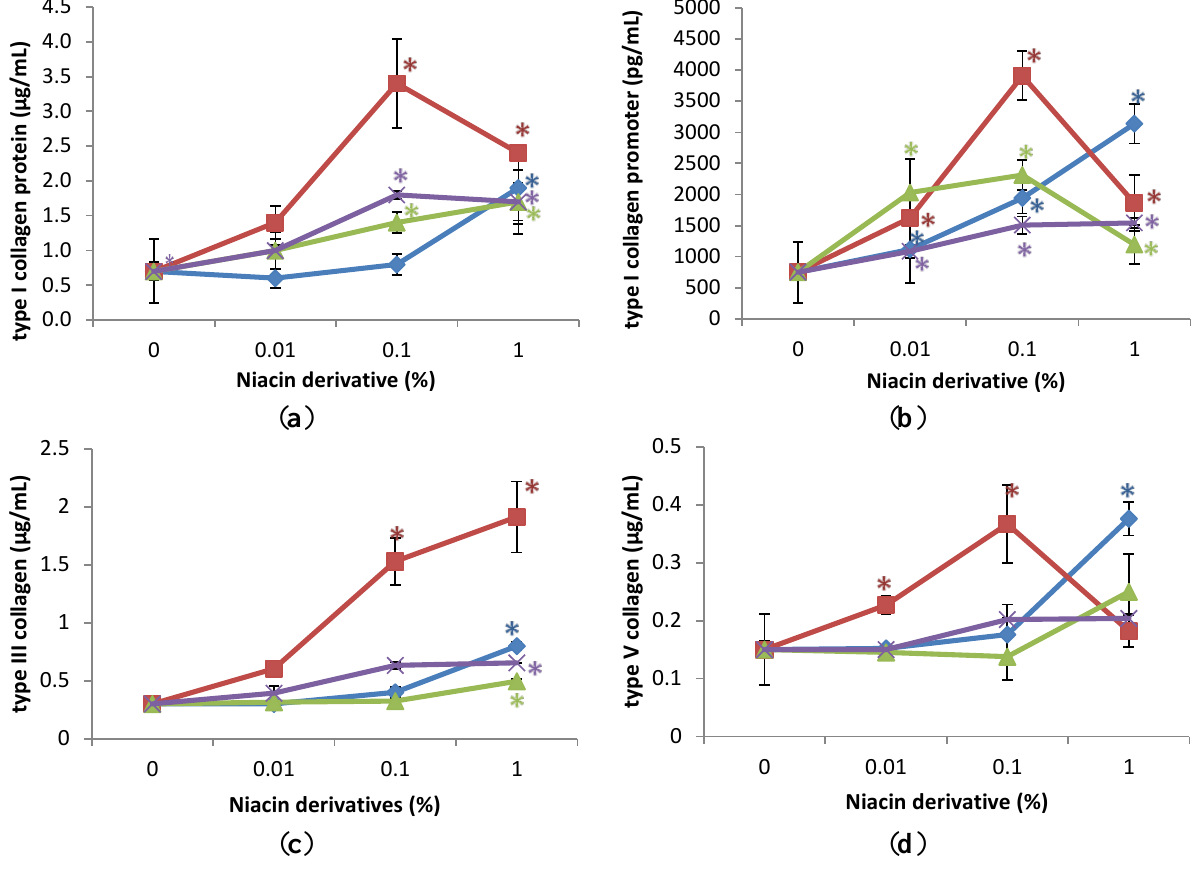
Figure 1. Stimulation of type I collagen protein ( a ); type I collagen promoter activity ( b ); type III collagen protein ( c ); and type V collagen protein ( d ) by nicotinamide (green line), 2,6-dihydroxynicotinamide (red line), 2,4,5,6-tetrahydroxynicotinamide (violet line), and 3-hydroxypicolinamide (blue line) in non-irradiated dermal fibroblasts; * p < 0.05, relative to control, error bars ( a – d ) represent standard deviation, n =